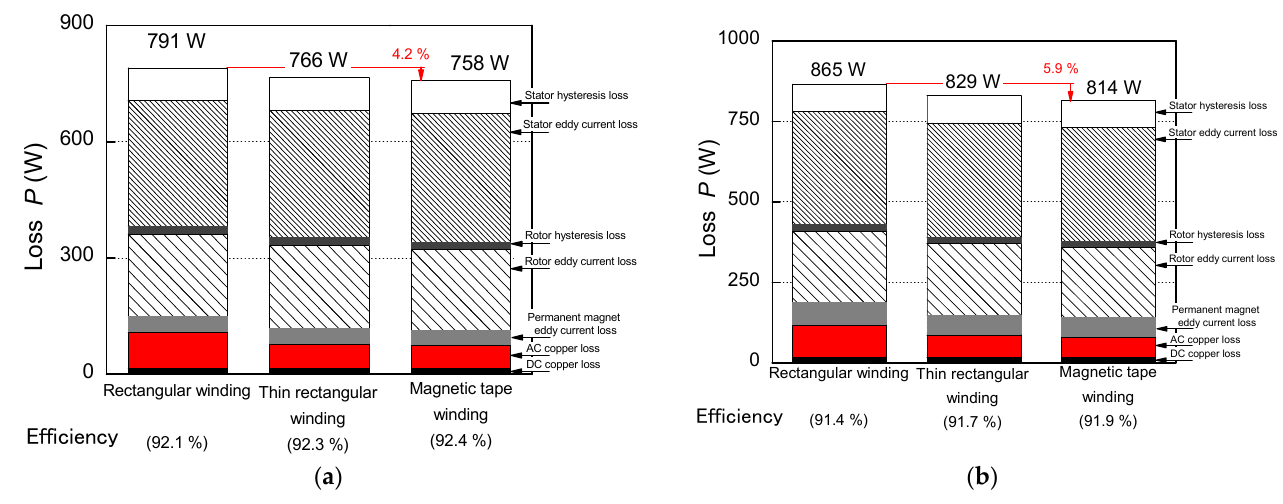
Figure 11. Loss characteristics of the motors ( P o = 10 kW, N r = 10,000 rpm): ( a ) fundamental; ( b ) 20% ripple.